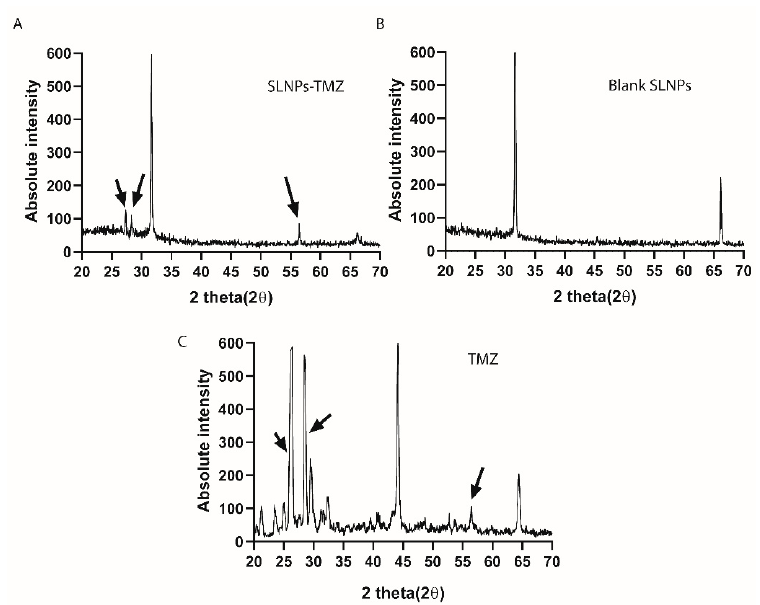
Figure 6. X-ray dispersive spectroscopy (XRDS), ( A ) SLNP-TMZ, ( B ) Blank SLNP, ( C ) X-ray Patterns of TMZ. The sharp peak between 26° and 28° of SLNP-TMZ suggests the amorphous nature of TMZ after conjugation with SLNPs. The arrows represent the changes in the peaks upon incorporation of TMZ into SLNPs.